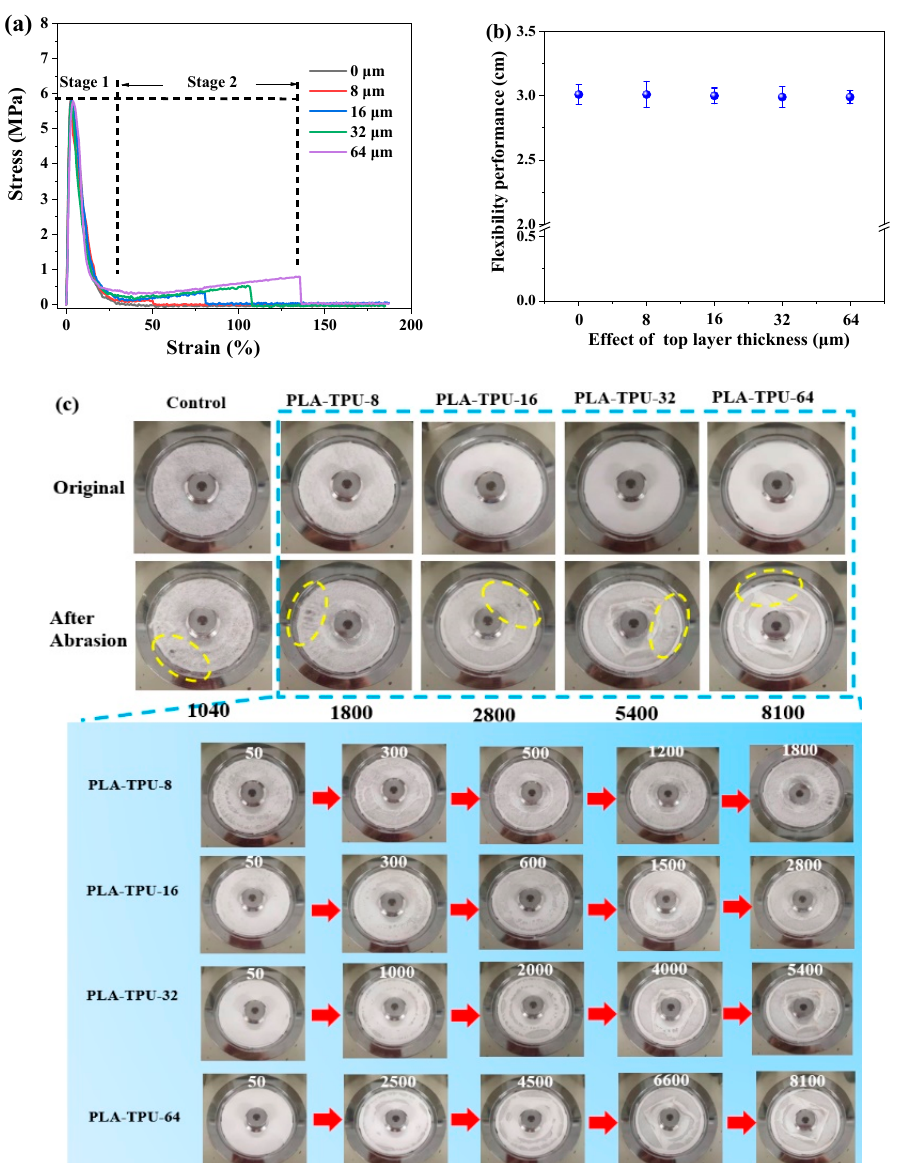
Figure 6. ( a ) stress–strain curves, ( b ) flexibility, and ( c ) abrasion resistance of micro-/nano-fibrous membranes as related to different TPU thicknesses.